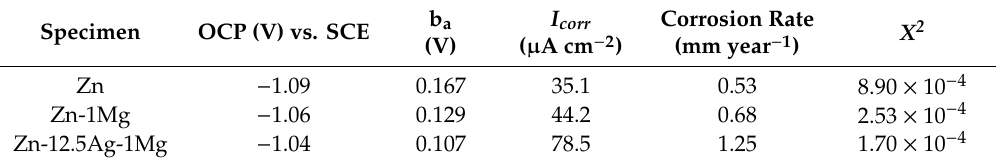
Table 5. Summary of corrosion data obtained from potentiodynamic polarization tests for the extruded specimens.